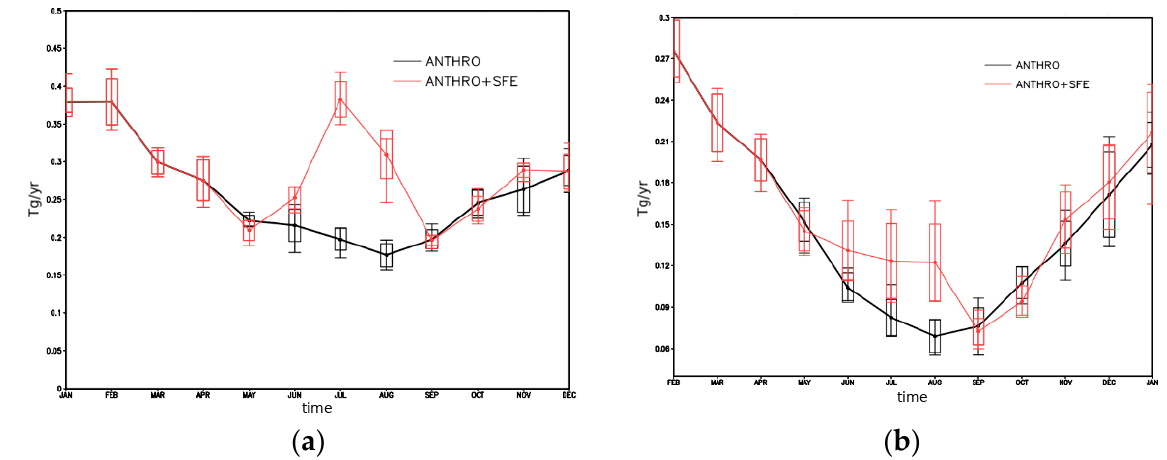
Figure 15. Annual variation of BC deposition on the surface: ( a ) in the Arctic (>60 N), ( b ) on sea ice in the Arctic, Tg/year. Black curves—anthropogenic emissions, red curves—anthropogenic and fire components.